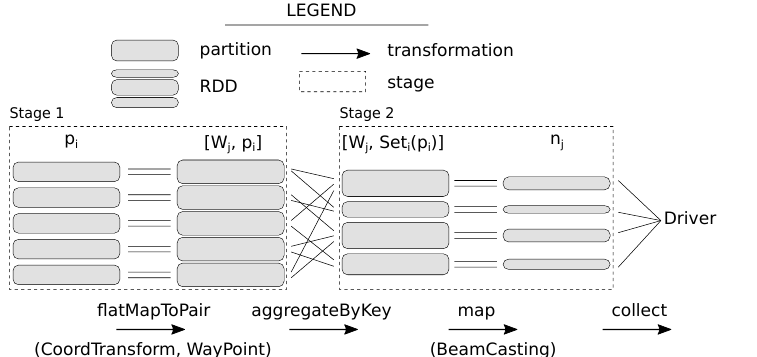
Figure 6. Data lineage corresponding to Algorithm 3, where in Stage 1, no cross-partition exchange is needed as the points within each partition are mapped to their corresponding way points. Sub- sequently, the data are shuffled among the partitions to aggregate the points by their way points. Ultimately, in Stage 2, the beam tracing algorithm is applied to each point data subset corresponding to individual way points to calculate the fitness score. No cross-partition exchange is needed in Stage